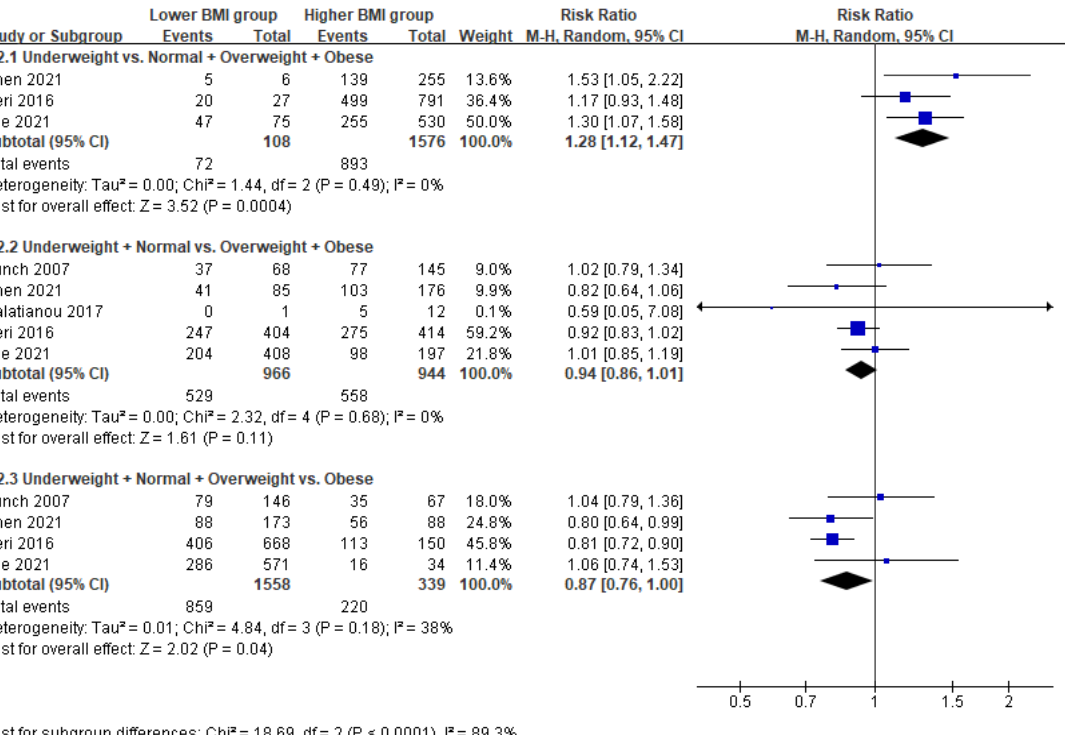
Figure 5. Forest plot of the association between body mass index and in-hospital mortality in patients with return of spontaneous circulation after out-of-hospital cardiac arrest.